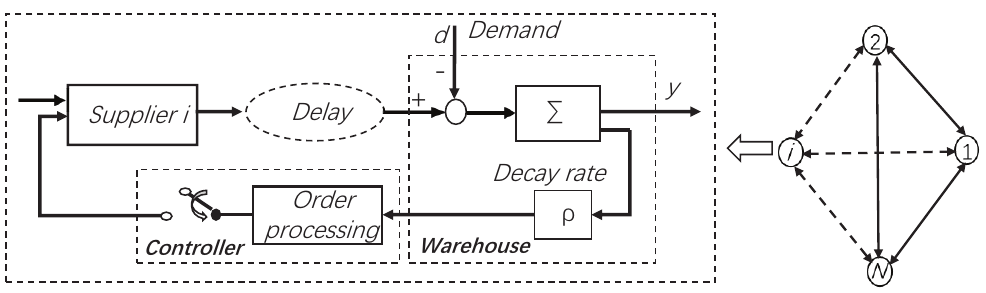
Figure 1. Multi-agent-based supply chain network with N